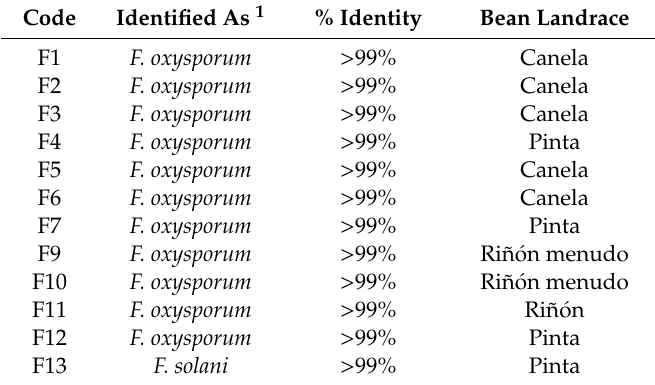
the Laboratory Diagnosis of Pests and Diseases” (PALDPD) Collection, University of Le ó n, Le ó n,